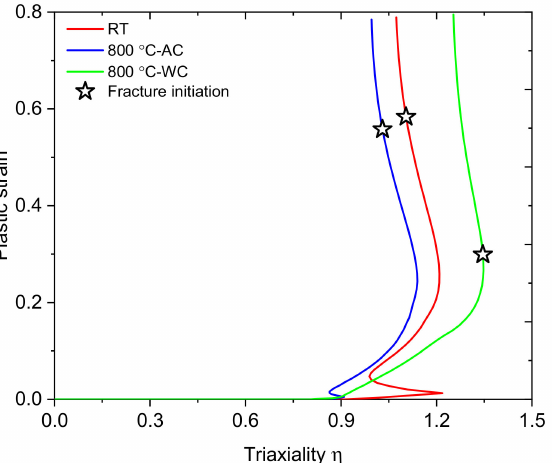
Figure 11. Effects of temperature and cooling method on the loading path of the CN3 specimens (star symbols denote the instance of fracture